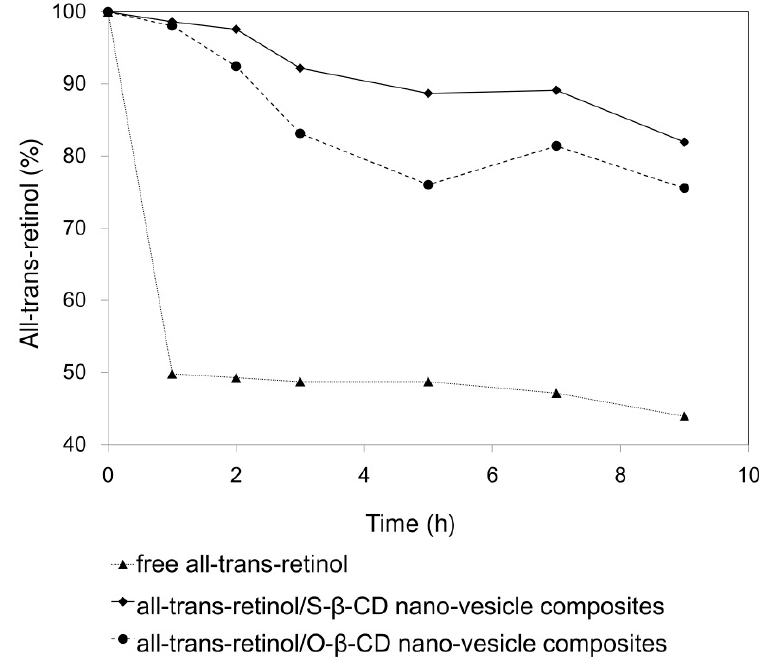
Figure 7. Photo-degradation curves, under UVA irradiation, of all- trans -retinol, all- trans -retinol/S- β -CD nano-vesicle composites, and all- trans -retinol/O- β -CD nano-vesicle composites in aqueous solution.